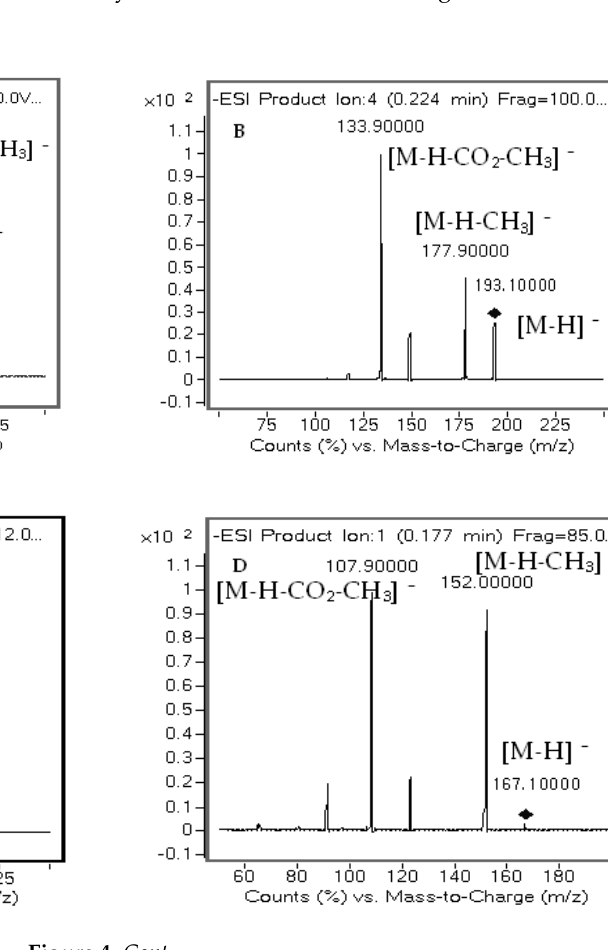
Figure 4. Other MRM parameters are displayed in Table S1.